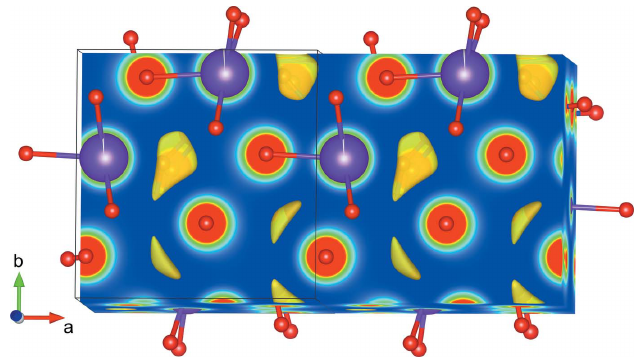
Figure 4 Calculated independent atom model electron density (Momma & Izumi, 2011) of the K-paracelsian structure. Yellow areas illustrate positions in the cage with minimum electron